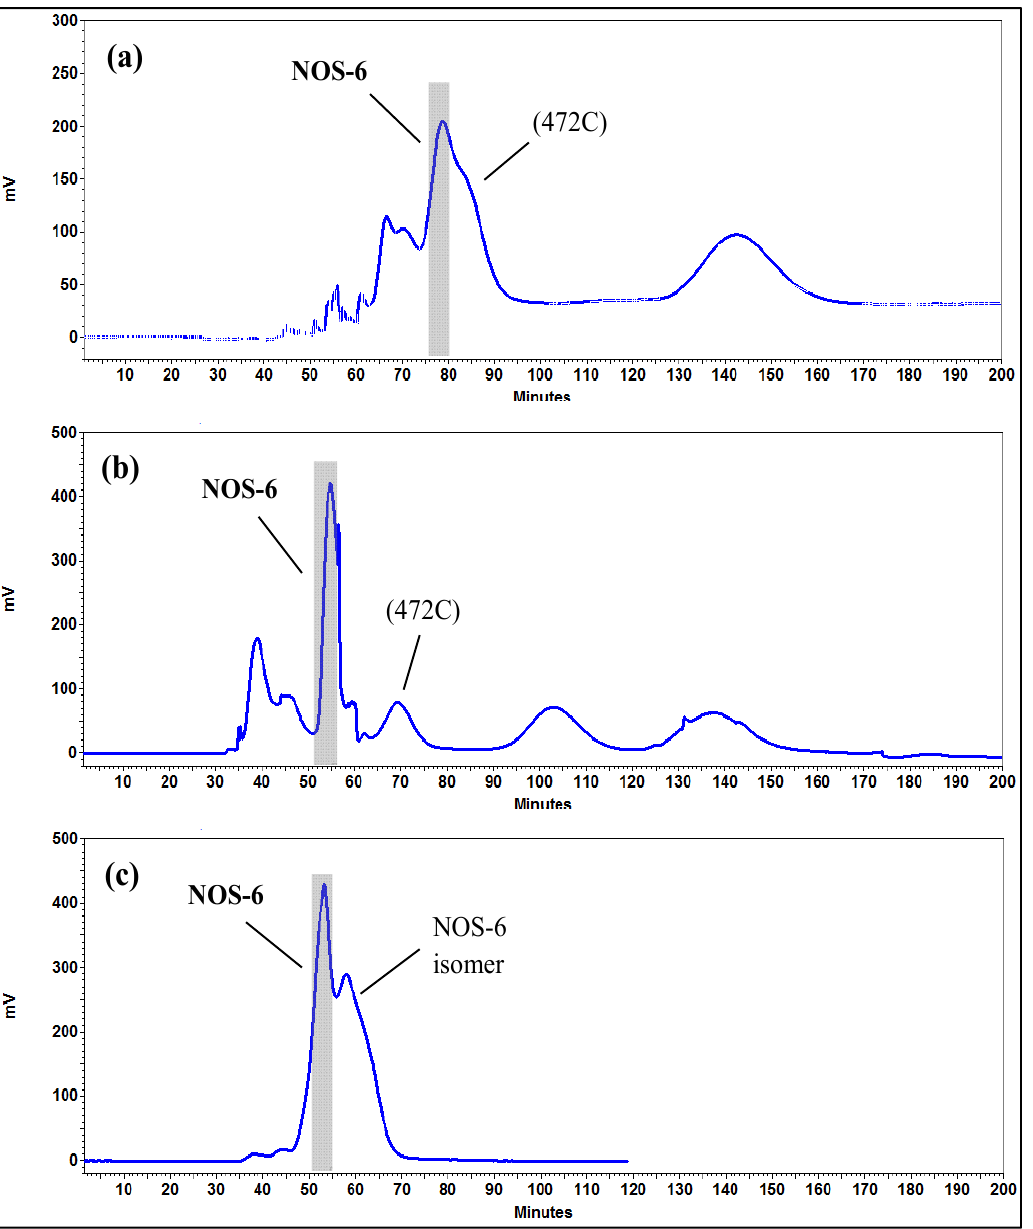
Figure 3. ( a ) HPCCC chromatogram of acetone-treated crude extract of Nostoc sp. Two phase solvent system: HEMWat, 4:5:4:5, v/v/v/v; mobile phase: lower phase; elution mode: reverse phase; flow rate: 1 mL/min; detection: 280 nm. ( b ) First-step HPCCC chromatogram of acetone-treated crude extract of Nostoc sp. Two phase solvent system: HEMWat, 4:5:4:5, v/v/v/v; stationary phase: neutral upper phase; mobile phase: base lower phase (1% NH in lower phase, pH 8.7); elution mode: reverse phase; flow rate: 1 mL/min; 3 detection: 280 nm; 472C: contaminant (ion at m/z 472 from HPLC/ESI-HRMS analysis). ( c ) Second-step HPCCC chromatogram of target fraction. Two phase solvent system: HEMWat, 4:5:4:5, v/v/v/v; stationary phase: neutral upper phase; mobile phase: neutral lower and base lower phase (1% NH in lower phase, pH 8.7) as mobile phase with a linear 3 gradient elution exchanged from 100:0 for 70 min and then to 0:100 for 130 min; elution mode: reverse phase; flow rate: 0.8 mL/min; detection, 280